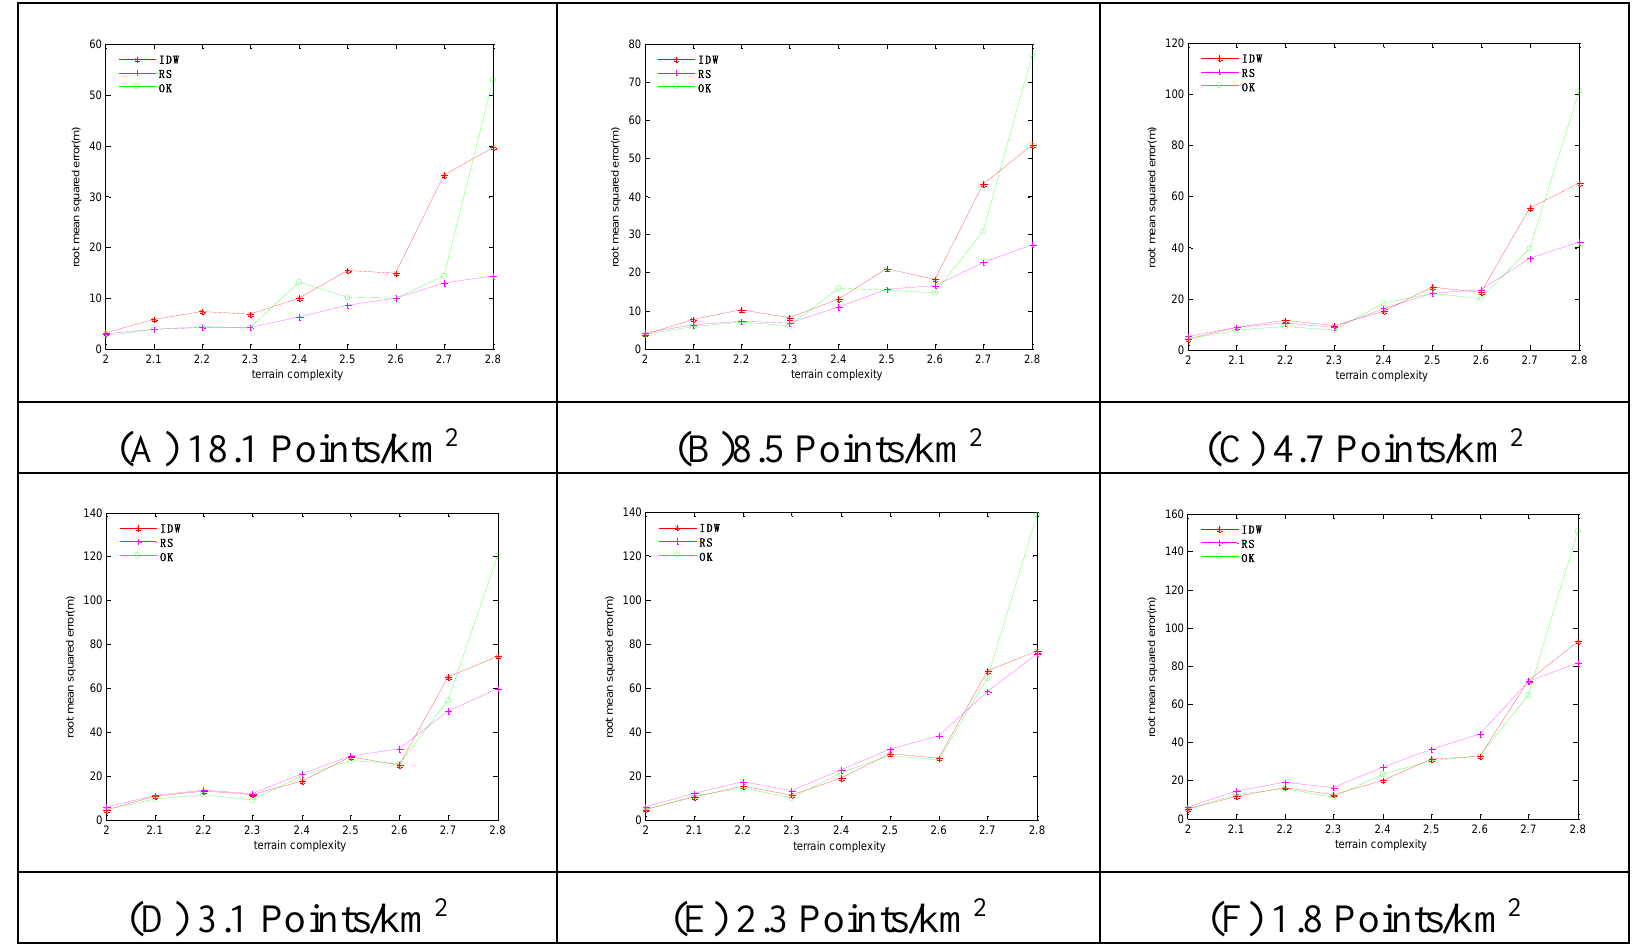
Figure 8. The RMSE s of the 3 methods in combined sampling. Sampling densities of ( A ) 18.1 points/km 2 ; ( B ) 8.5 points/km 2 ; ( C ) 4.7 points/km 2 ; ( D ) 3.1 points/km 2 ; ( E ) 2.3 points/km 2 ; ( F ) 1.8 points/km 2